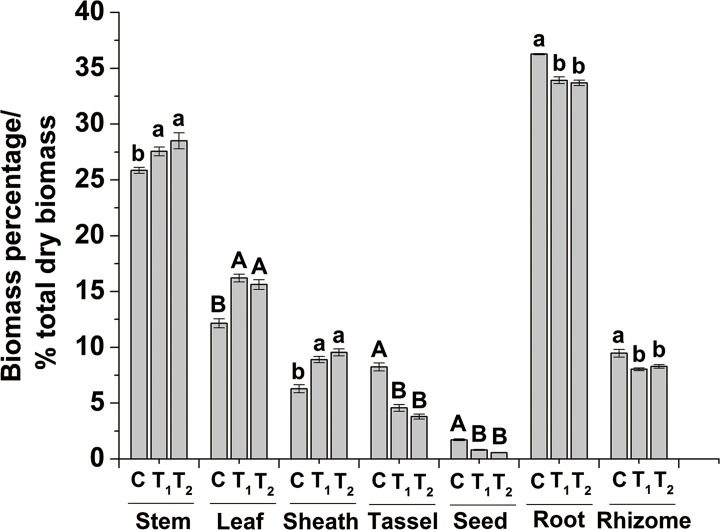
Biomass percentage of different organs in switchgrass with different photoperiods regulated.C indicates the control switchgrass, while T1 and T2 indicate the switchgrass with extended photoperiods of 18 and 24 h, respectively. The different small letters or capital letters in each group of columns indicate the significant difference at level of P < 0.05 or 0.01, respectively. The bar indicates SE (n = 5).